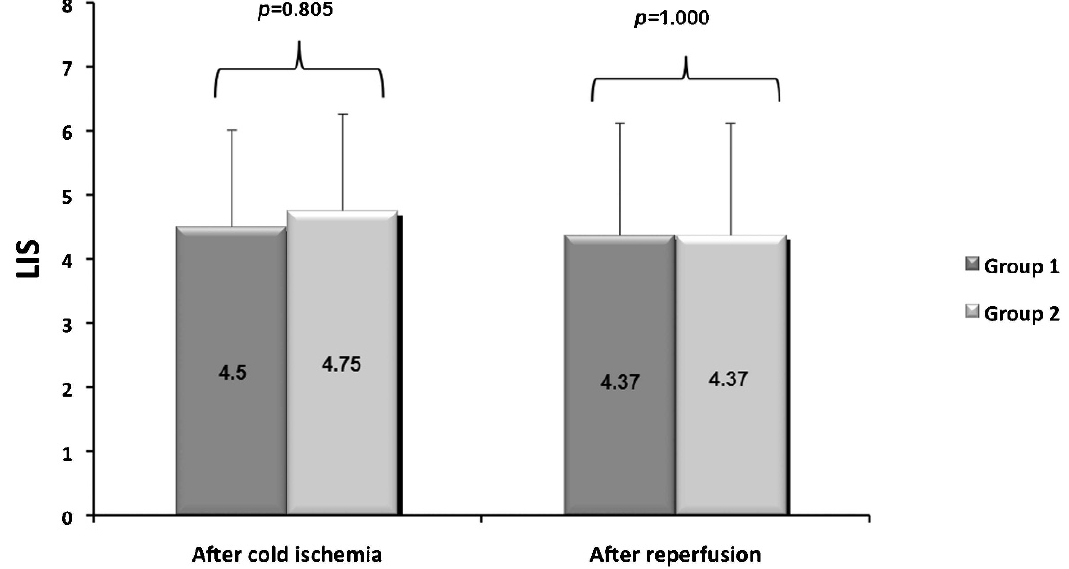
Figure 4 - There was no statistically significant difference in the Lung Injury Score (LIS) between the groups over time ( p= 0.855). The error bars represent the